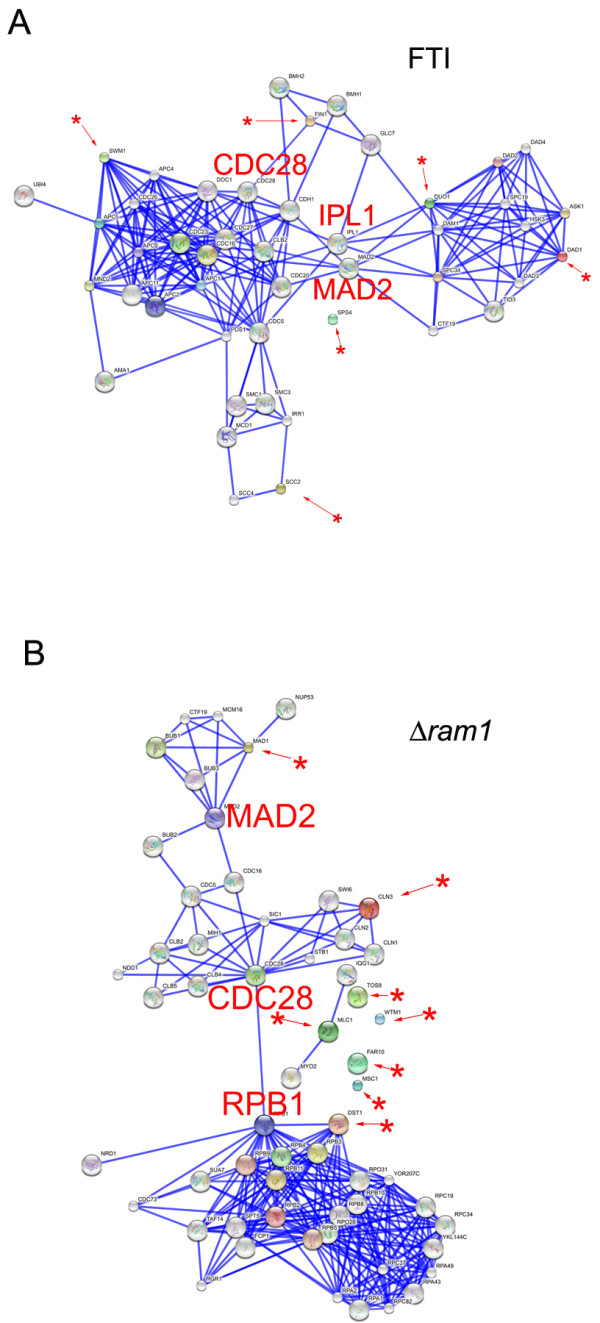
Network analysis of the cell cycle up-regulated transcripts in FTI-treated BY4741 and in Δram1 cells. Confidence view image of gene clusters acting in the cell cycle and up-regulated in (A) 10 μM FTI treated BY4741 cells and (B) Δram1 cells using the STRING analysis tool. Analyses were performed by setting the confidence score at the highest confidence (score = 0.900) and excluding text mining. Asterisks with a red arrow indicate the input proteins. The position of nodes CDC28, MAD2, IPL1 and RPB1 within the network is highlighted.